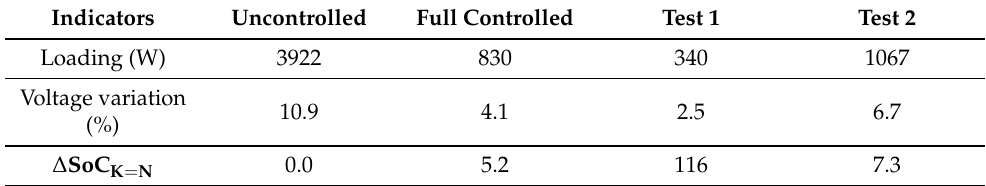
Table 3. Indicators